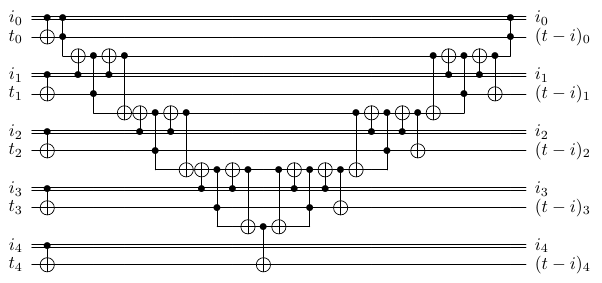
FIG. 5. A circuit to subtract a constant from a quantum register without storing that constant in qubits. The double lines indicate classical registers. The qubit at the bottom provides the output of an inequality test.